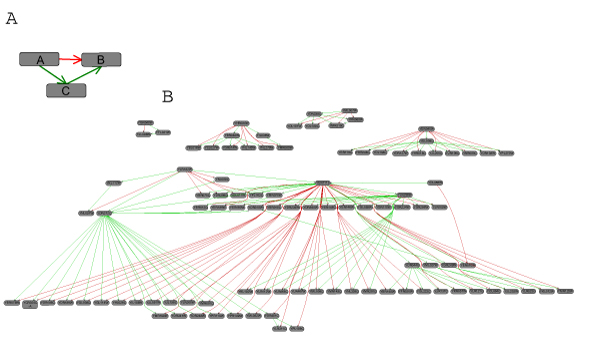
Direct and indirect effects. Red arcs are from the mutant network, green arcs from the ChIP network. A In the mutant where transcription factor A is deleted (disrupted) the expression of gene B is significantly different from its expression in the wild type. The transcription factor A does not bind to the putative promoter region of gene B (no green arc), but to the putative promoter region of transcription factor C, which in turn is found in the putative promoter region of gene B. This indirect path from A to B in the ChIP network might therefore explain the direct path in the mutant network. B All direct effects in the mutant network that could be explained by indirect paths via one additional transcription factor in the ChIP network.